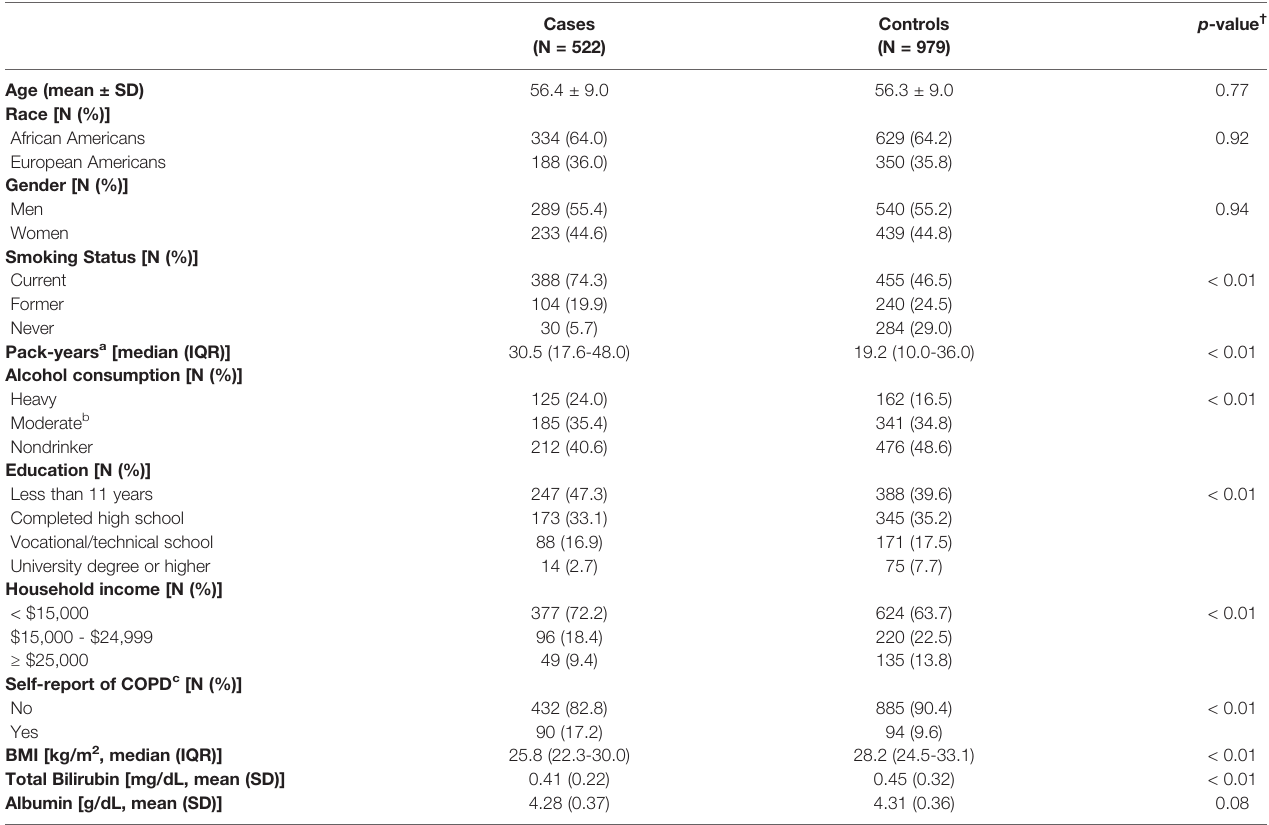
Table 1 . Lung cancer cases had a higher proportion of current TABLE 1 | Baseline characteristics of study population, SCCS.